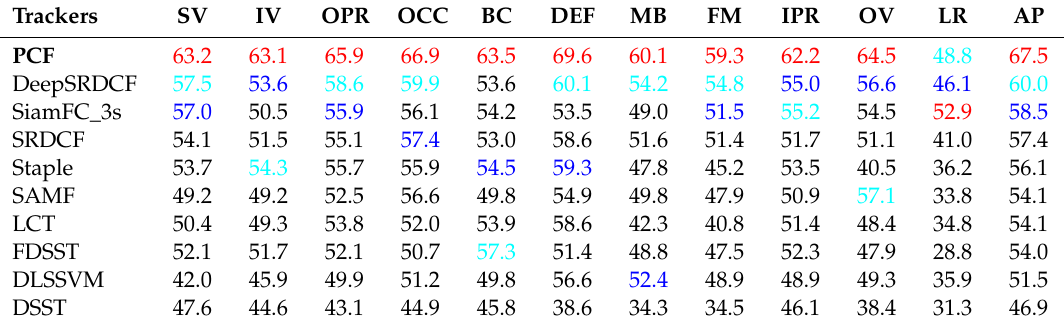
Table 5. The SP of the OPE on OTB-2013 benchmark for the top ten trackers on eleven different attributes (%): SV, IV, OPR, OCC, BC, DEF, MB, FM, IPR, OV, LR. The last column is the average overlap accuracy of the OPE. The top three ranks are marked in red , cyan , and blue respectively. Trackers DeepSRDCF